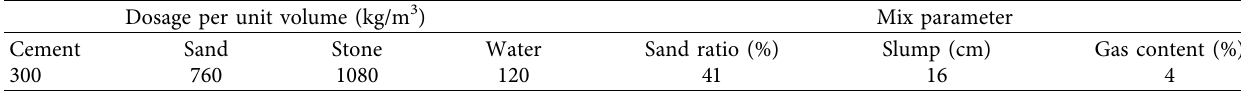
Table 1: Mix proportion of concrete.